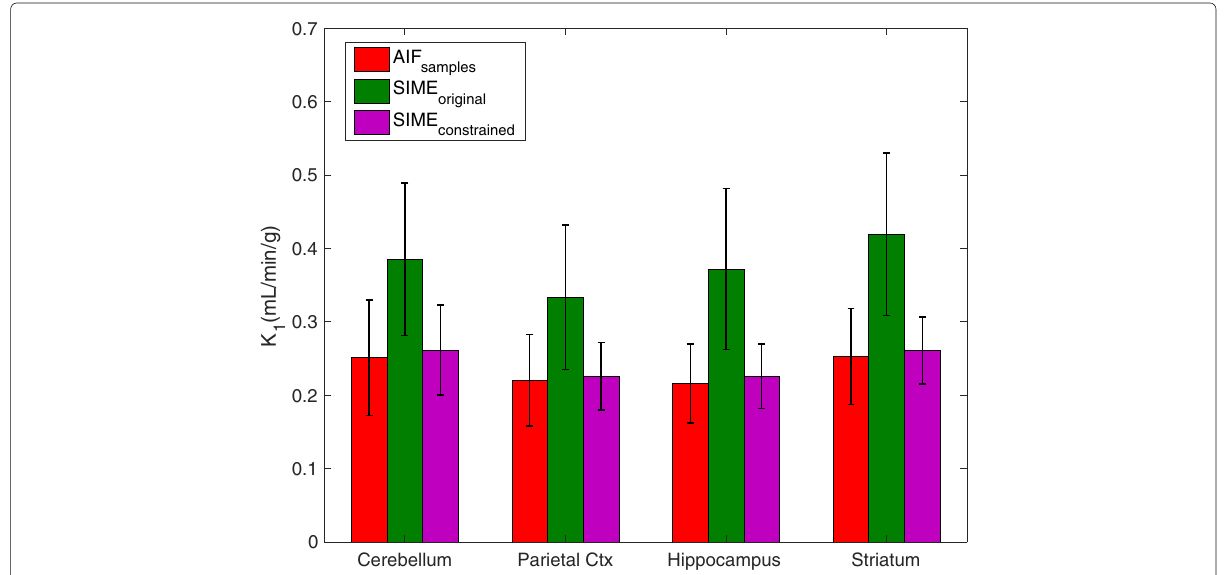
Fig. 7 K 1 estimated for four brain regions using the AIFs estimated from AIF samples , SIME original and SIME constrained . The bars represent the K 1 values estimated across 10 studies and error bars represent the standard